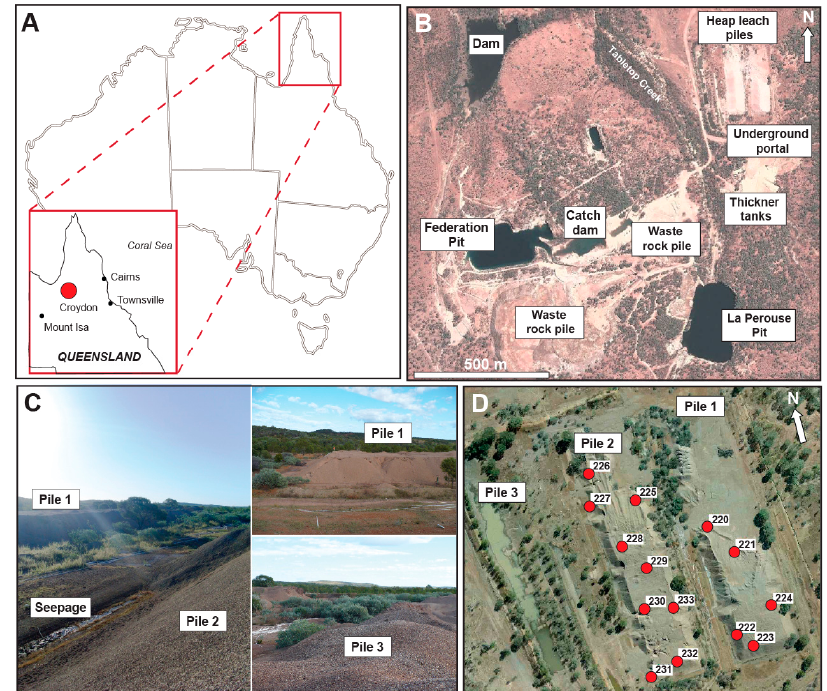
Figure 1. ( A ) Map of Australia with the location of the Croydon mining district shown in the inset; ( B ) Croydon mine workings, showing the abandoned Federation/La Perouse site (image from Google Earth); ( C ) Heap leach piles with seepage observed at the base; ( D ) Heap leach sample locations (220 to 233).